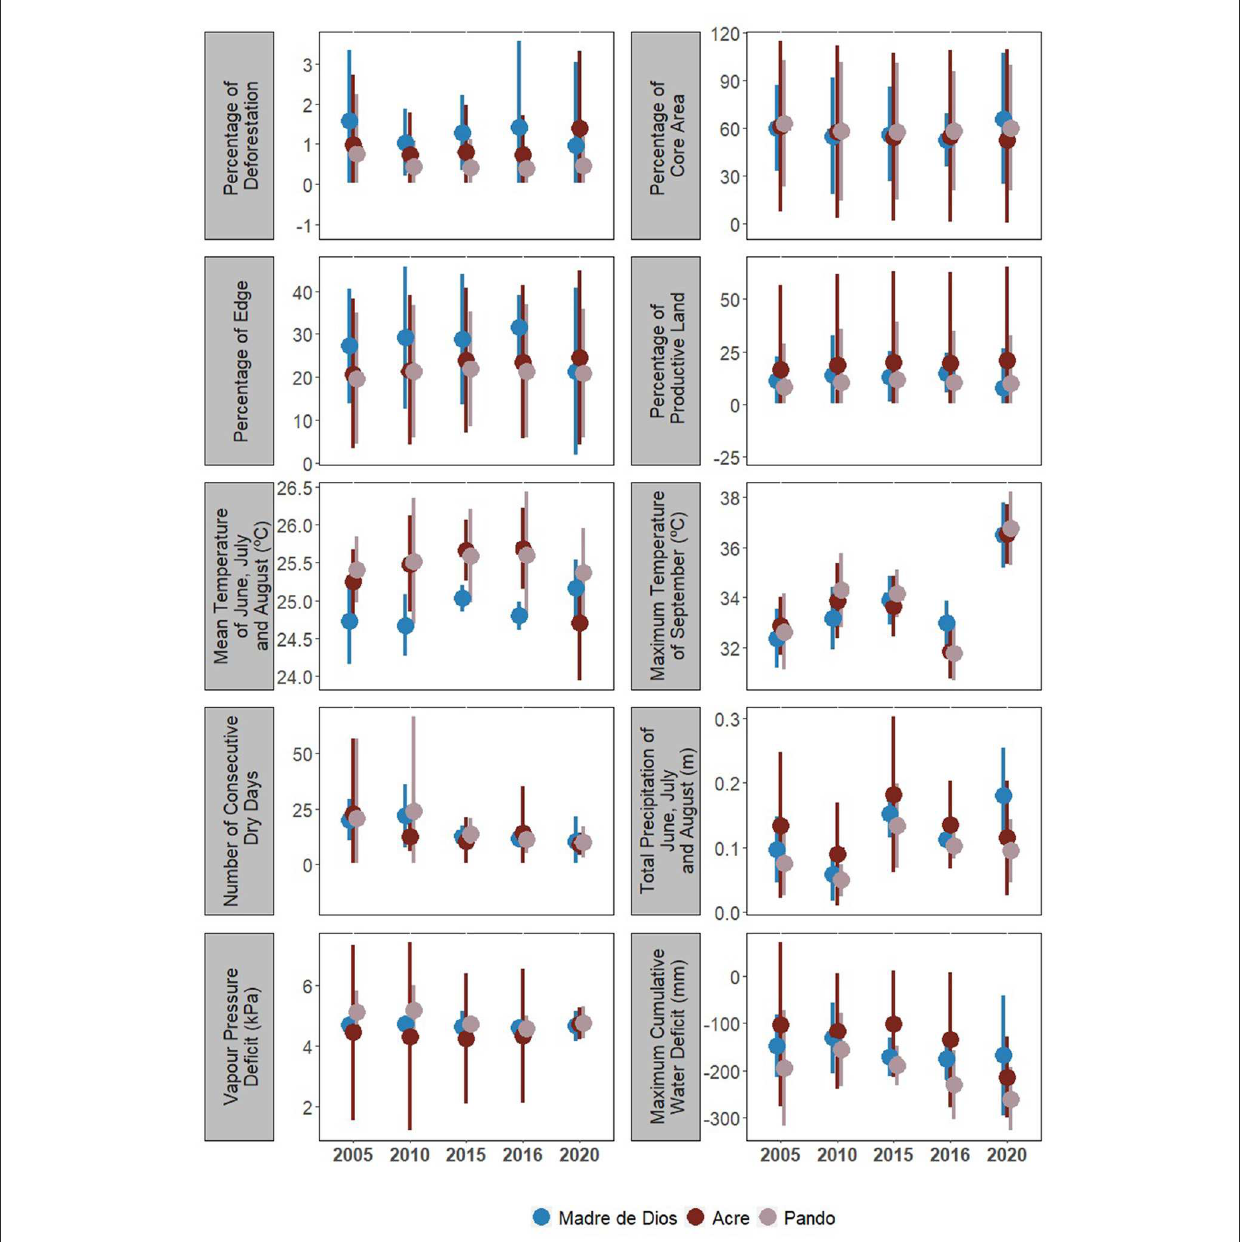
FIGURE8 Distribution of human and climatic drivers for fire occurrence in the MAP region for 2005, 2010, 2015, 2016, and 2020. The colored points represent the median value of each MAP region distribution, and the vertical lines are the minimum and maximum range of the